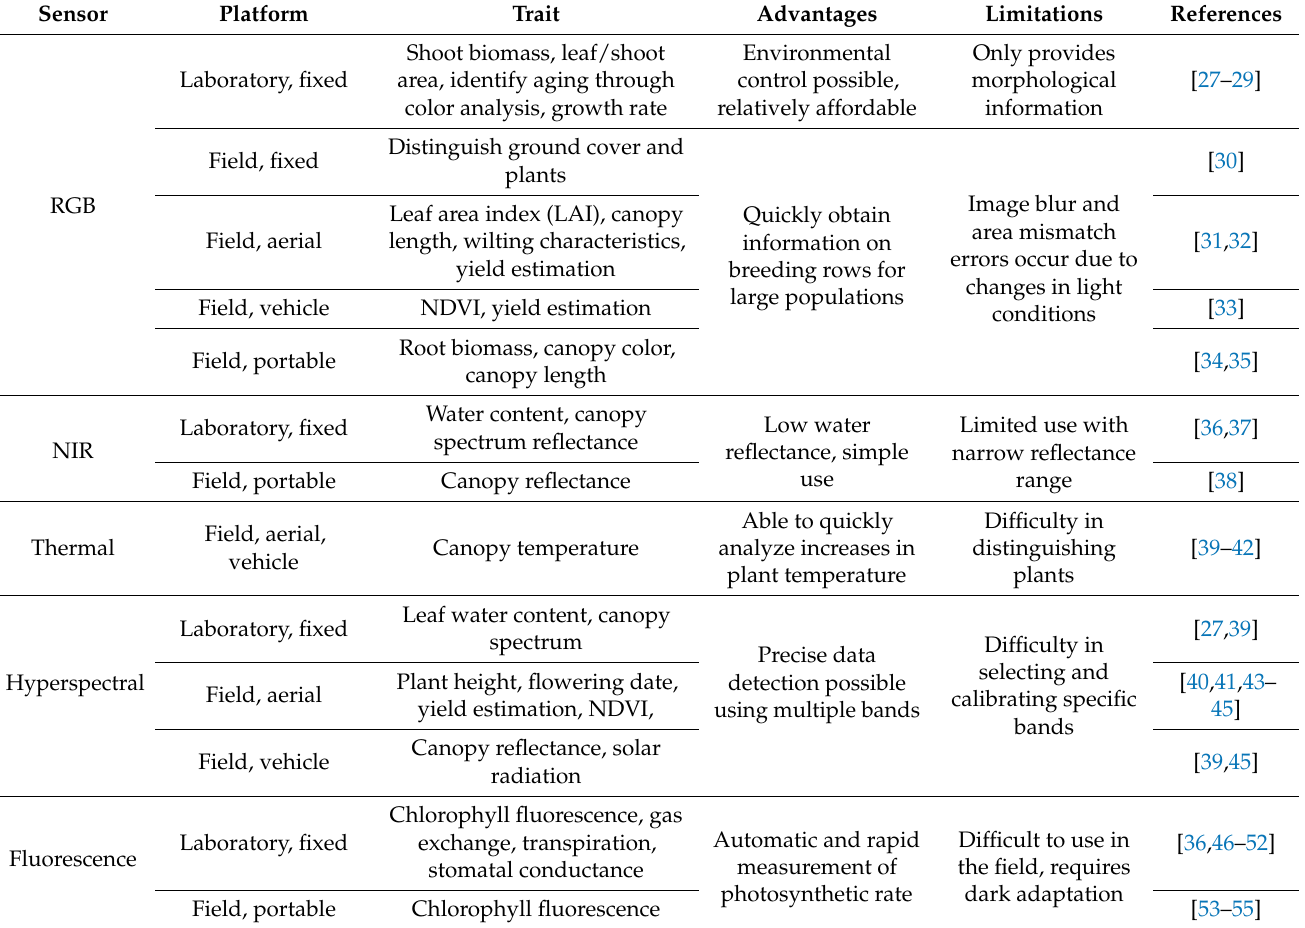
Table 1. Sensors used for high-throughput phenotyping of plants under drought stress. Sensor Platform Trait